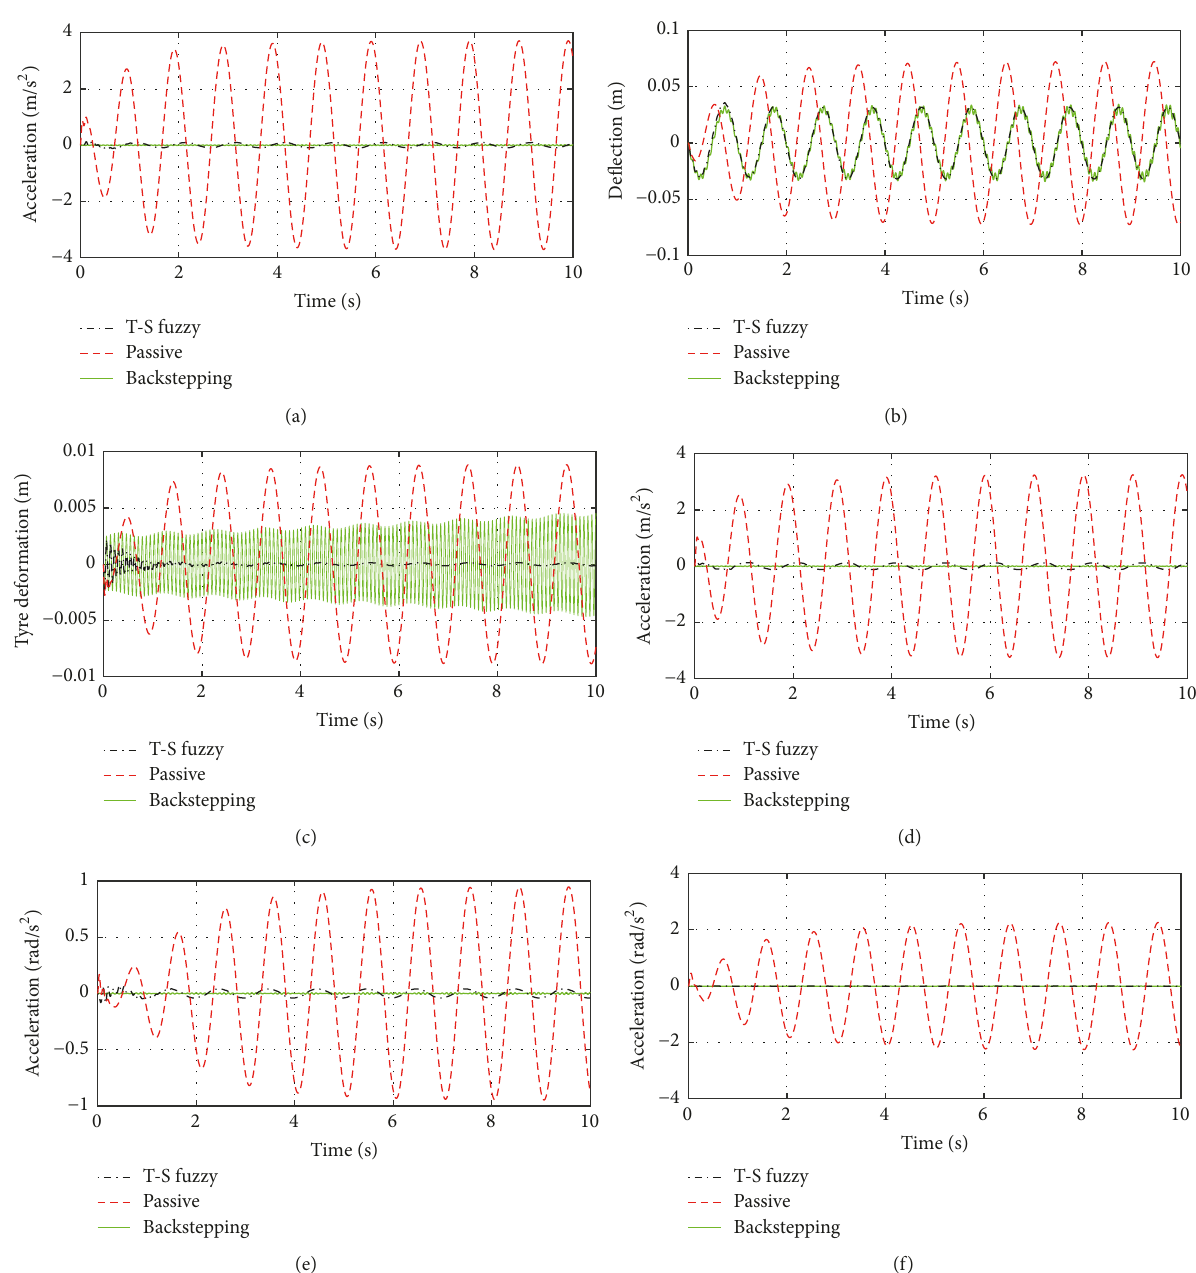
Figure 3: Output response for a mild road perturbation (0.03 m): (a) acceleration response of front right corner; (b) dynamic deflection of front right corner; (c) tyre deformation of front right corner; (d) acceleration response of the center of mass; (e) acceleration response of the pitch motion; (f) acceleration response of the roll